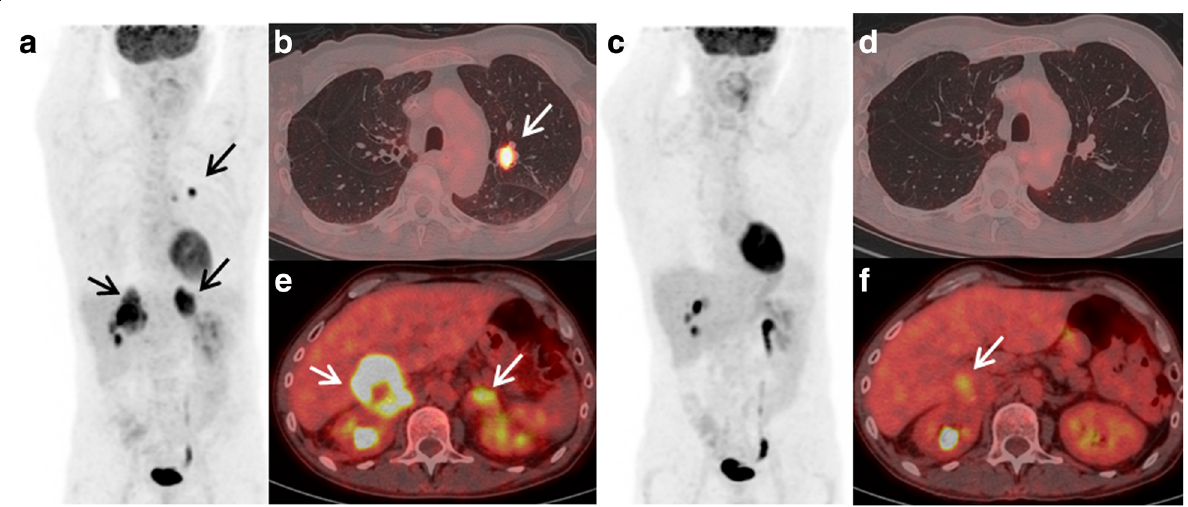
Fig. 2 A 64-year-old patient with metastatic lung adenocarcinoma was treated with a second line of nivolumab. SCAN-1 shows lung nodules with adrenal metastases ( a , maximum intensity projection (MIP) image, arrows; b , e axial fusion). SCAN-2 at 8 weeks of treatment (4 cycles) showing partial metabolic response (PMR): complete metabolic response on the lungs and left adrenal lesions ( c MIP, d axial fusion) but persistent and significant FDG uptake on the right adrenal lesion ( f arrow). The classification was PMR according to iPERCIST. Nivolumab treatment was maintained for 10 months, and at the last follow-up, the patient was still alive (survival of 23.8